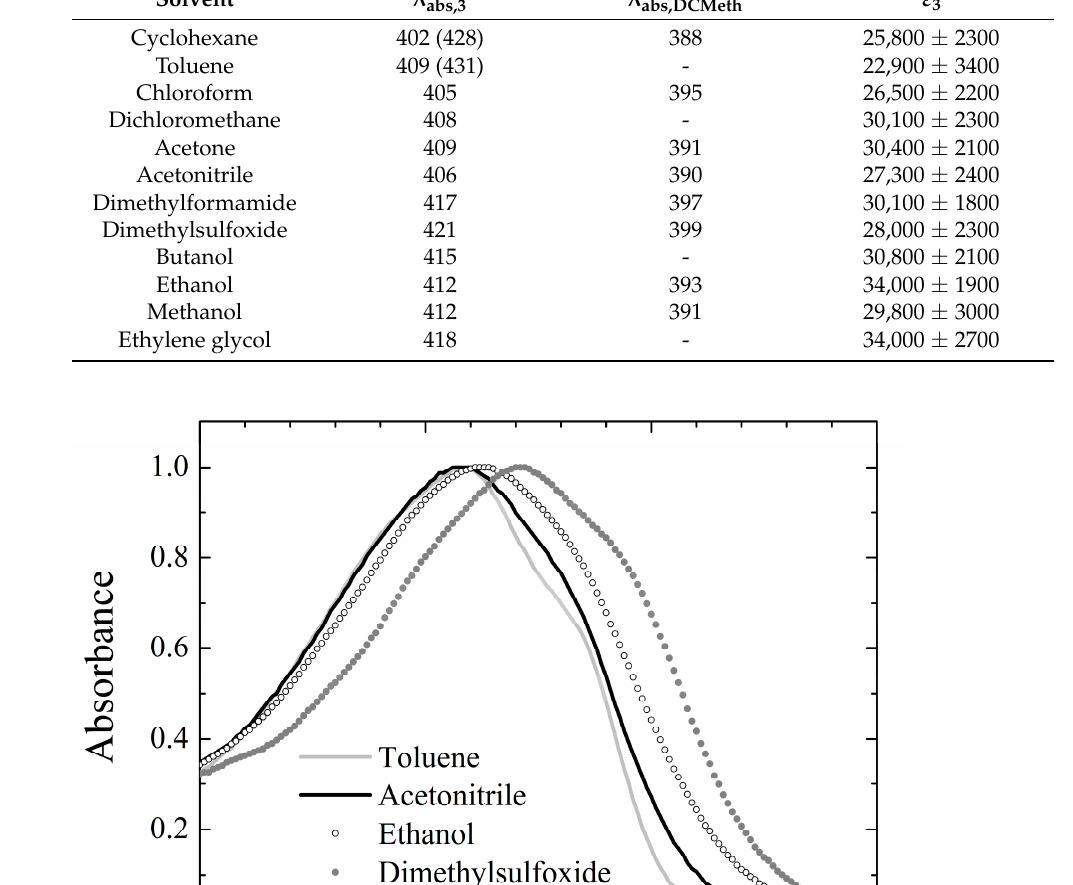
, is compared to abs, 3